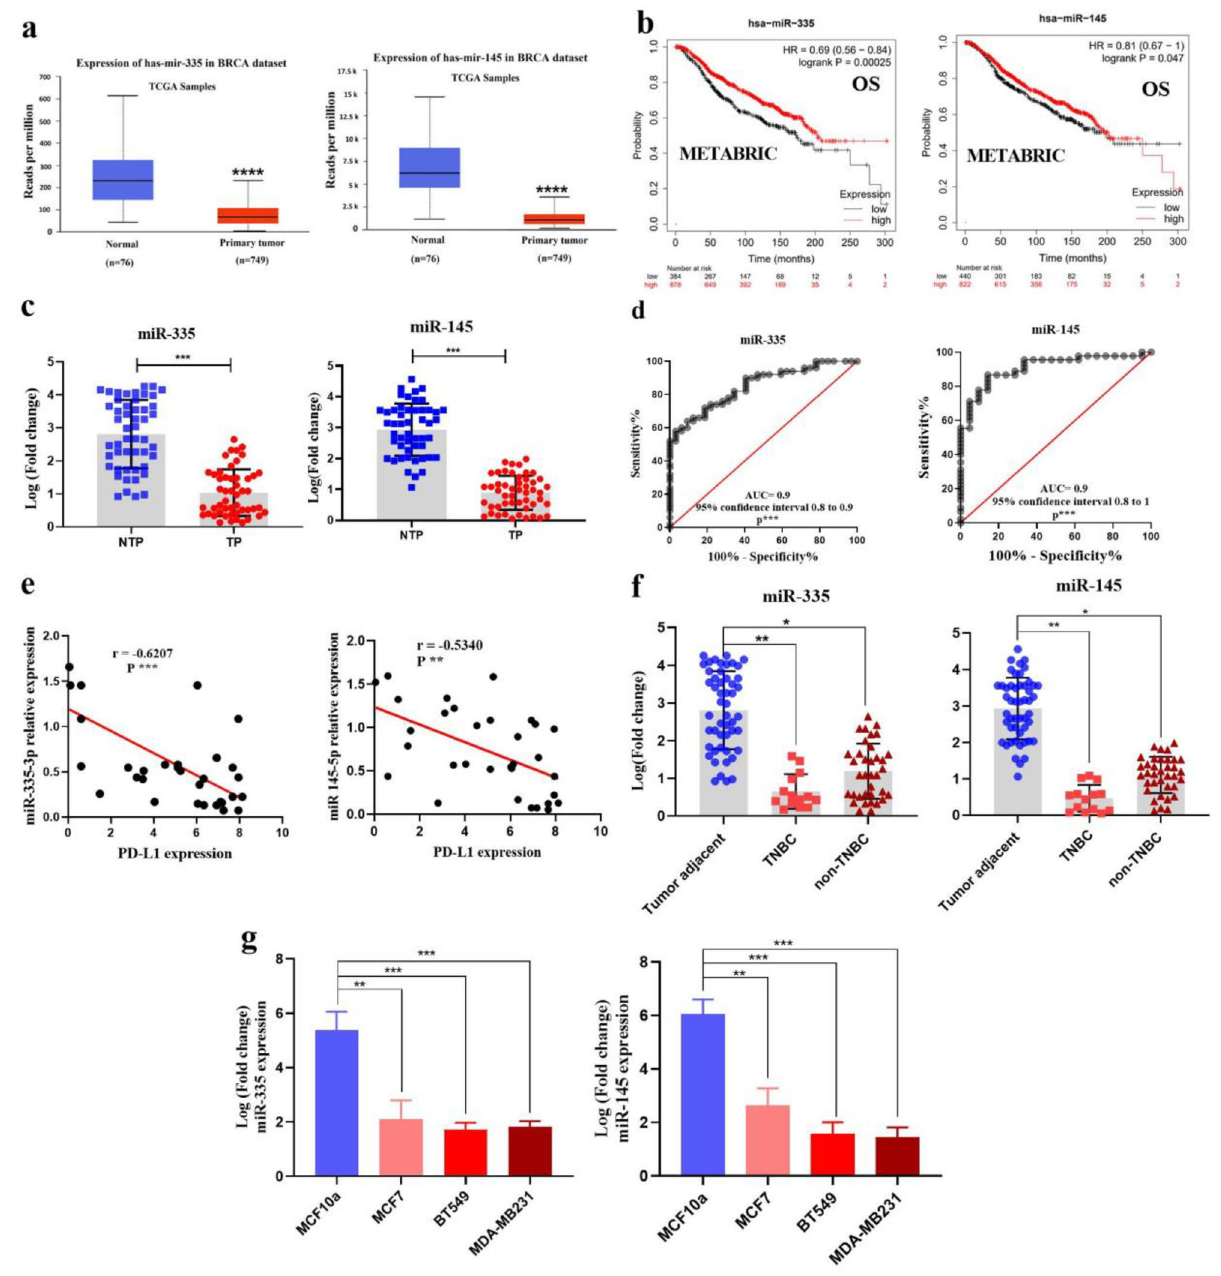
Figure 3. miR ‐ 335 and -145 expressions were analyzed in BC tissue samples and cell lines. ( a ) Analysis of miR-335 and -145 expression in BC via TGCA samples ( b ) The Kaplan–Meier plotter shows lower levels of miR-335 and -145 expression in primary breast tumors are associated with stronger and poorer, respectively, overall survival in the METABRIC (n = 1078) breast cancer patient datasets ( c ) miR ‐ 335 and -145 expression were downregulated in BC tissues as compared with normal samples using qRT ‐ PCR ( d ) Receiver operating characteristics (ROC) and area under the curve (AUC) for miR-335 and -145 ( e ) Decreased expression of miR-335 and-145 was correlated with PD ‐ L1 mRNA level (r = − 0.6207, r = − 0.5431, respectively, Pearson correlation) ( f ) The correlation between miR-335 and-145 expression and the TNBC or non-TNBC status of the tumor ( g ) Expression of miR-335 and -145 in BC cell lines compared to normal breast tissue samples; ***P ≤ 0.001; **P ≤ 0.01; ns = non-significant. The results were expressed as the mean ± SE of the experiments. BC, Breast Cancer; mRNA, messenger RNA; PD ‐ L1, programmed death-ligand 1; qRT ‐ PCR, quantitative reverse